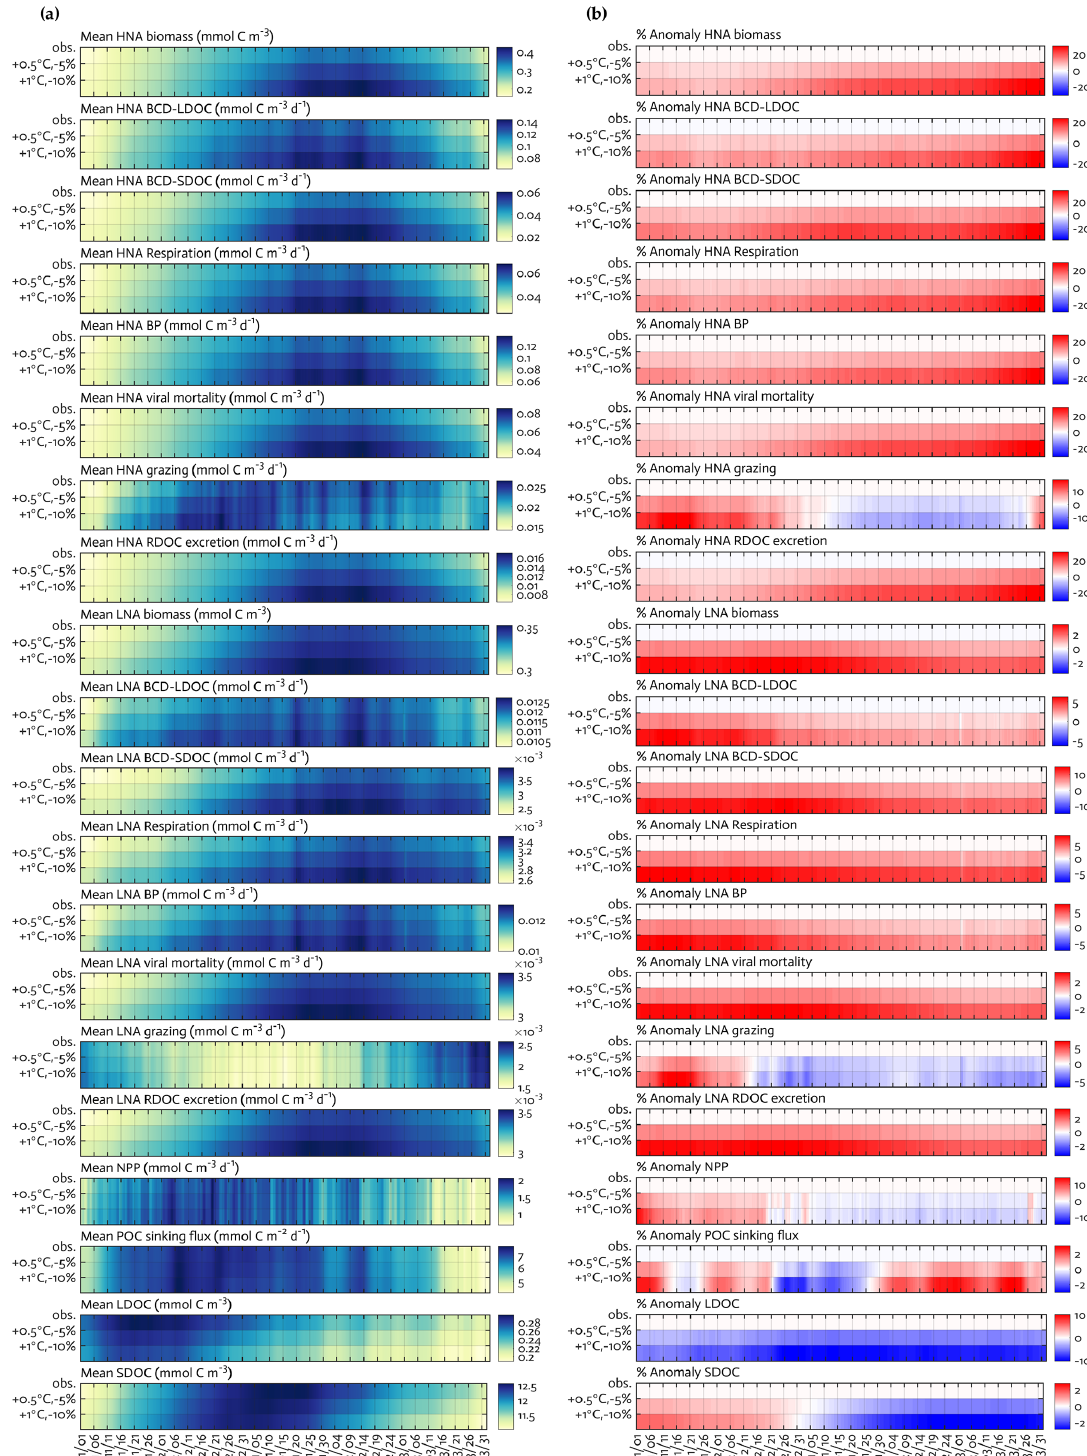
Figure 7. Climate change experiments. Seasonal progression of the modeled HNA and LNA bacterial carbon stocks and rates and key ecosystem functions under observed physical forcing and climate change experiments (a) and the percent change in the corresponding variable compared to observed fields in the second and third row of each panel, with the first row of each panel as zero to represent base states (b) . For example, the percent anomaly of HNA biomass in (b) = (HNA biomass under + 1 ◦ C and − 10% − HNA biomass under observed forcing) · 100 / HNA biomass under observed